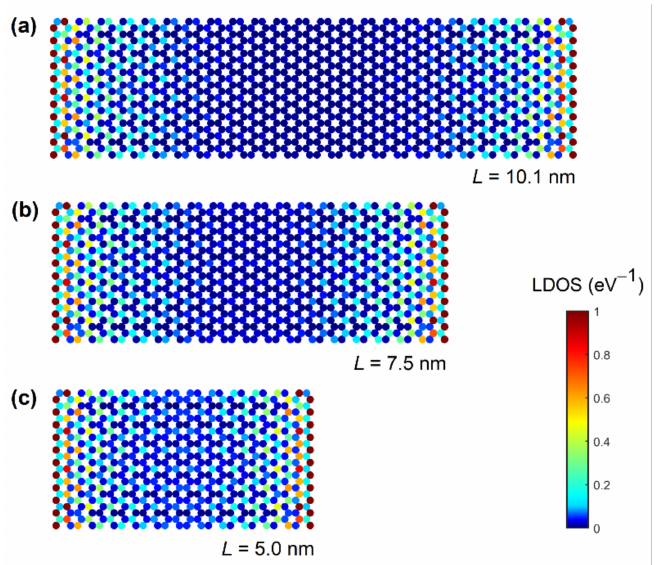
Figure 5. Local density of states in 2.6 nm-wide GNRs with 1D edge contacts for different GNR lengths: ( a ) 10.1 nm, ( b ) 7.5 nm, and ( c ) 5.0